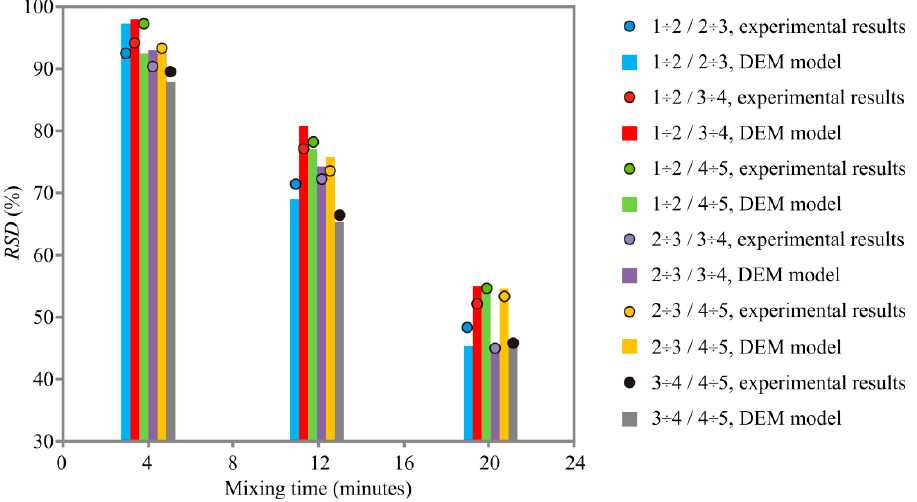
Figure 6. The RSD results in Experiment #2.